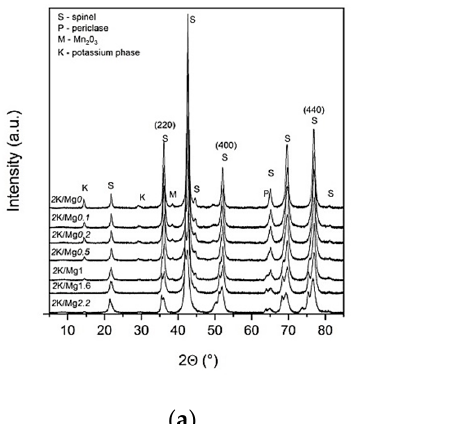
Table 2. Results of temperature-programmed reduction by hydrogen (TPR-H 2 ) and